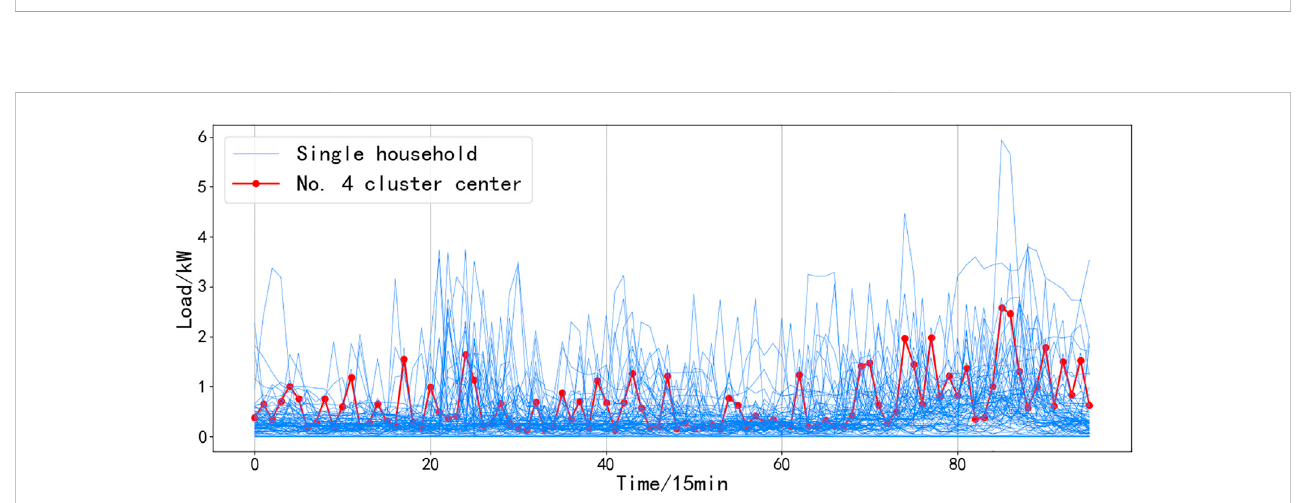
FIGURE 7 Category 1 of residential electricity mode and the clustering center of